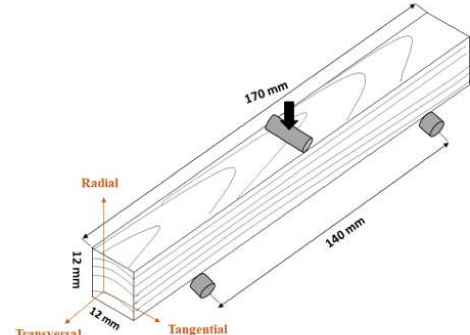
Figure 2. Scheme showing the wood specimens dimensions, and assembly positions for three-point bending test measurements (adapted from